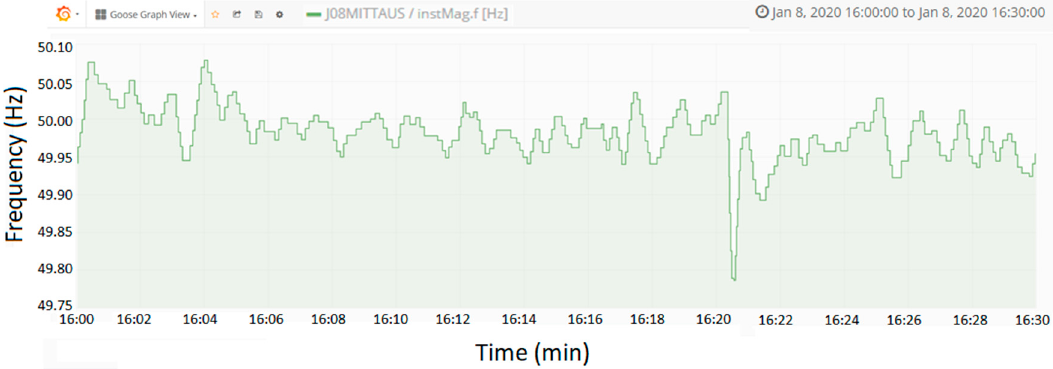
Figure 5. Measured 30 min real-life frequency data from SSG (which is modified for PSCAD simulations to 240 s frequency input data between t = 10–250 s, see Figure 6a). Appl. Sci. 2020 , 10 , x FOR PEER REVIEW